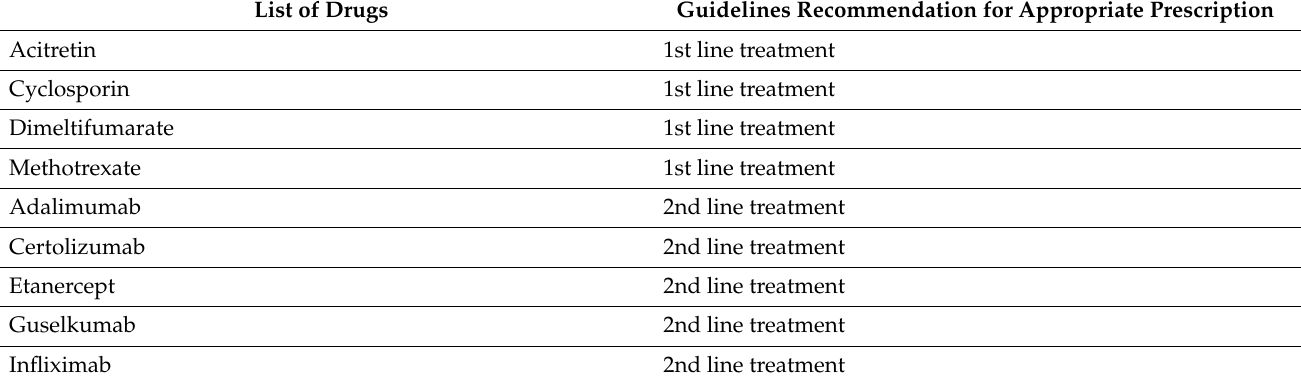
Table 4. This table reports the line of treatment each drug for psoriasis should be preferably adminis- tered to consider the prescription as